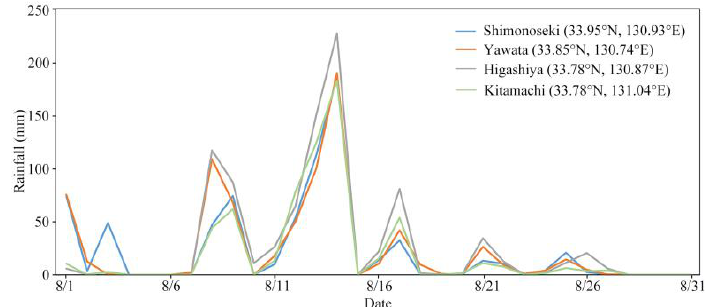
Figure 5. Daily rainfalls in August at various monitoring stations.